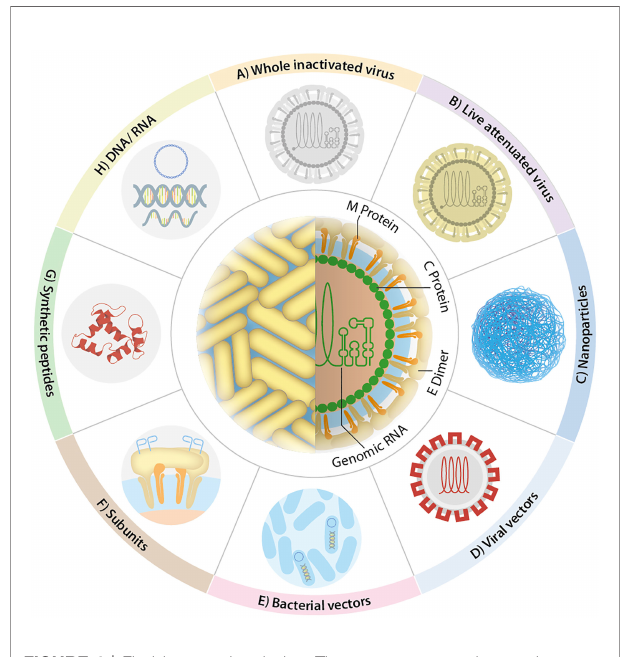
FIGURE 4 | Flavivirus vaccine design. The most representative vaccines against fl aviviruses use: (A) whole inactive virus, (B) live-attenuated virus, (C) nanoparticles, (D) viral vectors, (E) bacterial vectors, (F) subunits, (G) synthetic peptides, and (H) nucleic acids. Other strategies have been included in some of the depicted ones, e.g., liposomes (C) , virus-like particles (D) , bacterial ghosts (E) , fusion proteins (F) .